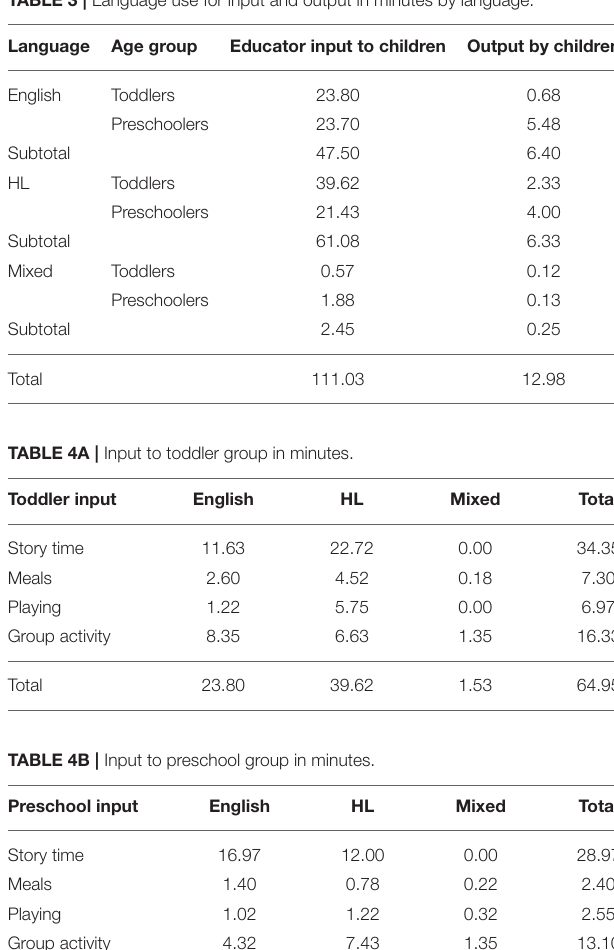
TABLE 3 | Language use for input and output in minutes by language.